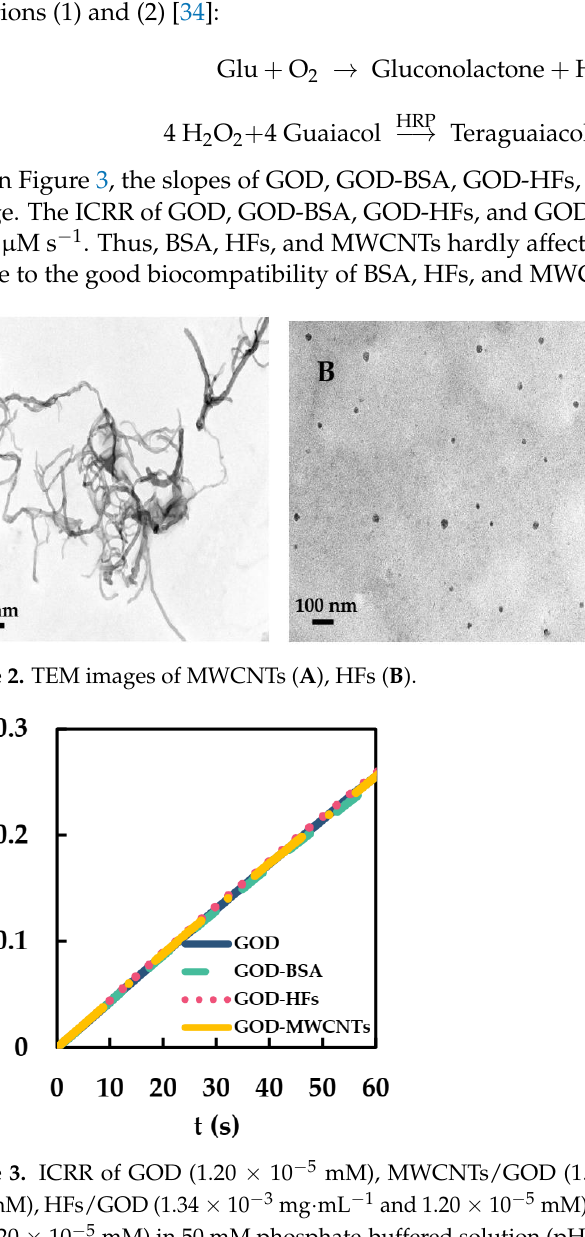
Figure 3. ICRR of GOD (1.20 × 10 −5 mM), MWCNTs/GOD (1.34 × 10 −3 mg ‧ mL −1 and 1.20 × 10 −5 mM), HFs/GOD (1.34 × 10 −3 mg ‧ mL −1 and 1.20 × 10 −5 mM), and BSA/GOD (8.00 × 10 −6 mM and 1.20 × 10 −5